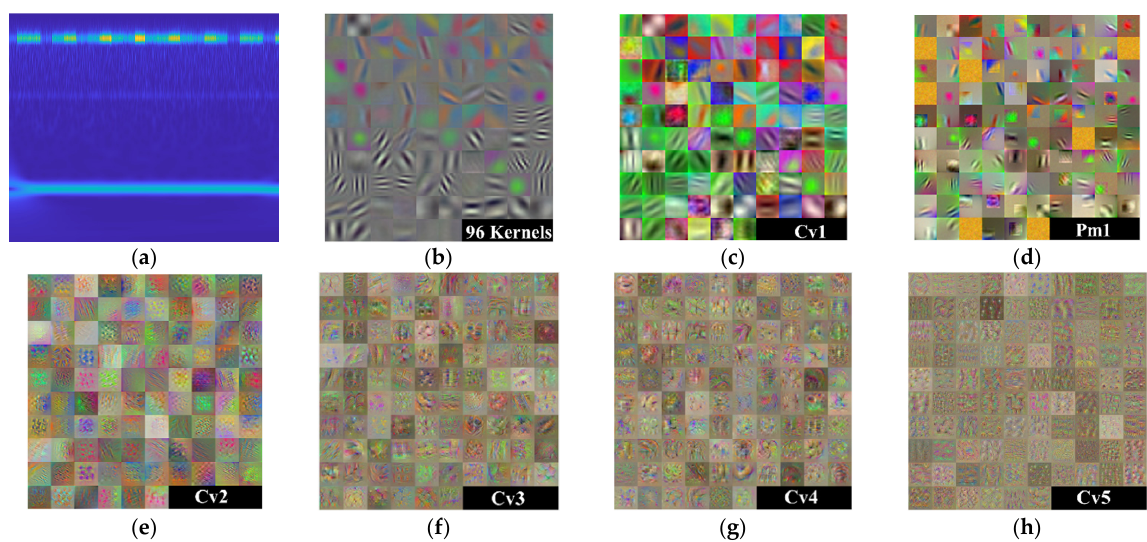
Figure 12. The flowing learned feature images through layers of the proposed DCNA for one example channel, here, ( a ) RGB input image, ( b ) the 96 kernels of size 11 × 11 ( c ), the feature images of the Cv1, ( d ) the feature images of the Pm1, ( e ) the feature images of the Cv2, ( f ) the feature images of the Cv3, ( g ) the feature images of the Cv4, the feature images of the Cv5 ( h ).